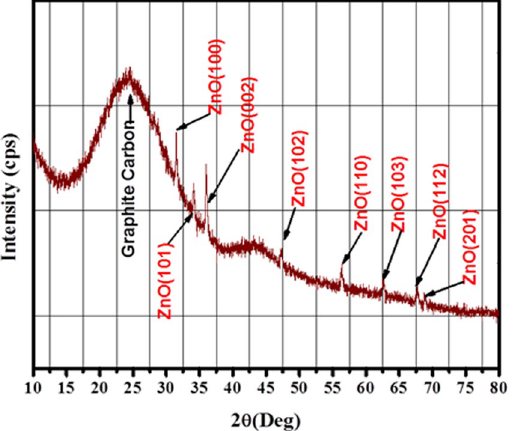
Figure 2. XRD pattern for the obtained core@shell (ZnO@C) microspheres after carbonized at 700 °C for 2 h in nitrogen atmosphere.